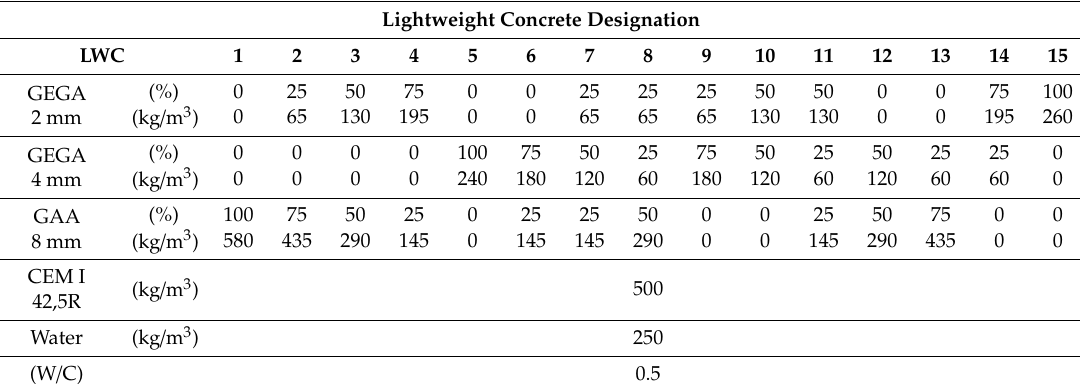
Table 5. Details of lightweight concrete mix